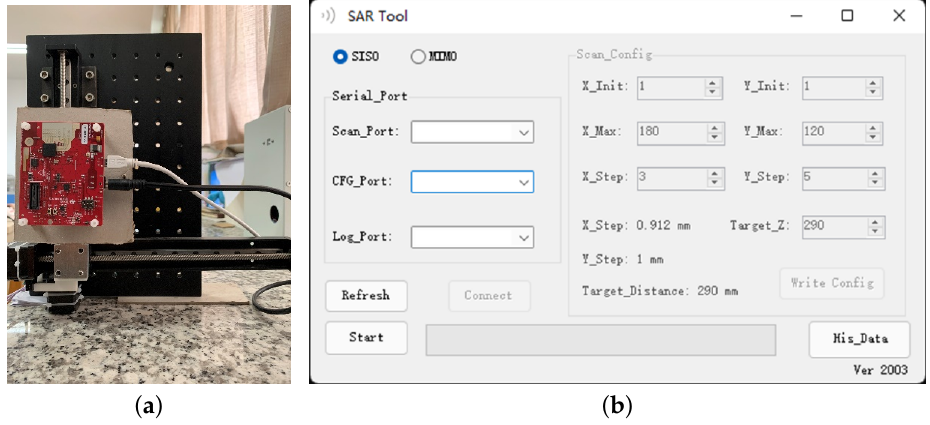
Figure 9. Near-field SAR testbed: ( a ) hardware structure; ( b ) software UI.